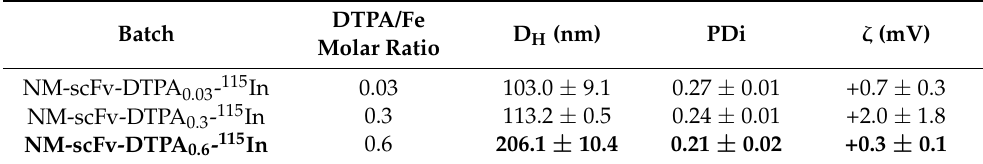
Table 4. Physico-chemical properties of NM-scFv after the complexation with InCl 3 . DTPA/Fe Batch Molar